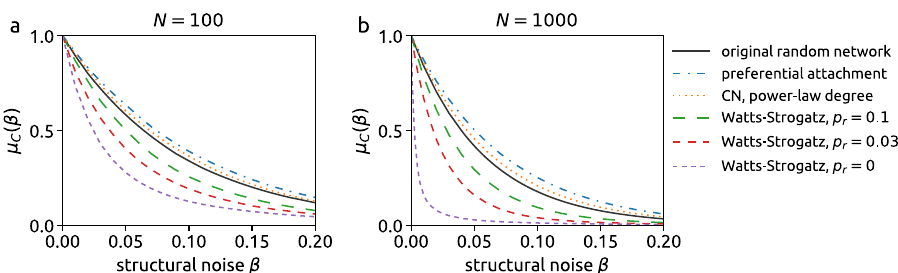
Fig. 4 Opinion consistency for various topologies of synthetic relation networks. The dependence of mean opinion consistency, μ C , on structural noise, β , for one seed opinion and different numbers of subjects: a N = 100 and b N = 1000. The results are averaged over 1000 model realizations on each of 1000 network realizations, mean degree z ≈ 4 for each network topology. The error bars are too small to be shown. CN and p r stand for the con fi guration model and the rewiring probability in the Watts – Strogatz model, respectively.